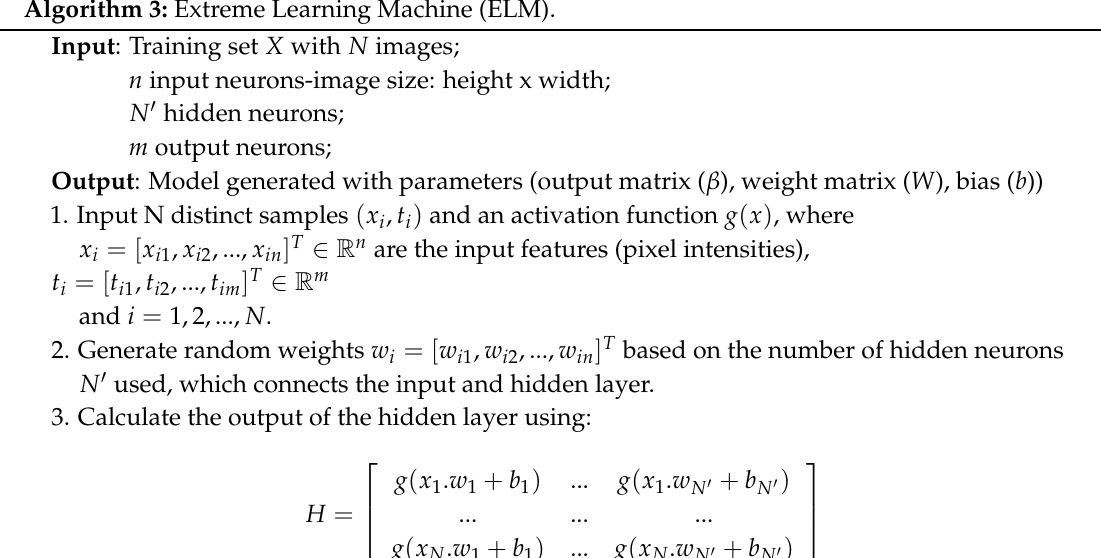
Algorithm 3: Extreme Learning Machine